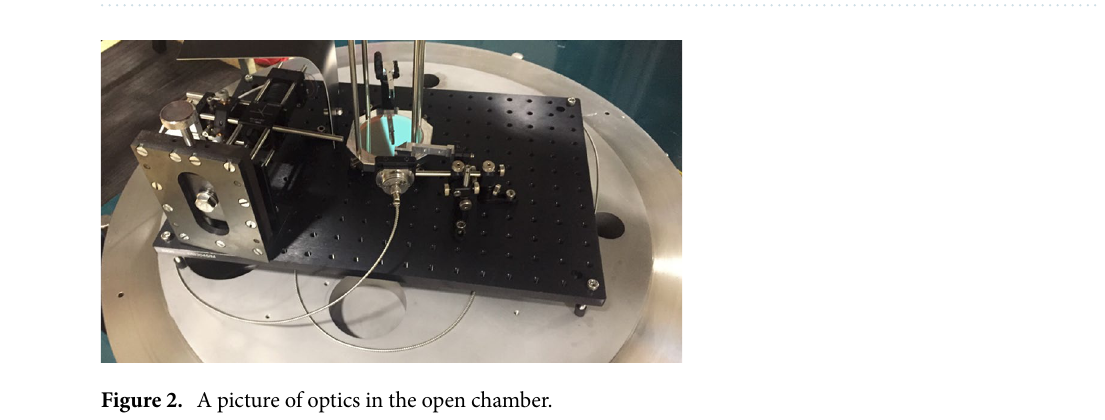
Figure 1. The schematic diagram of the experimental setup. All optics and detectors are placed inside the vacuum chamber. The electronic equipment and the laser are kept outside.